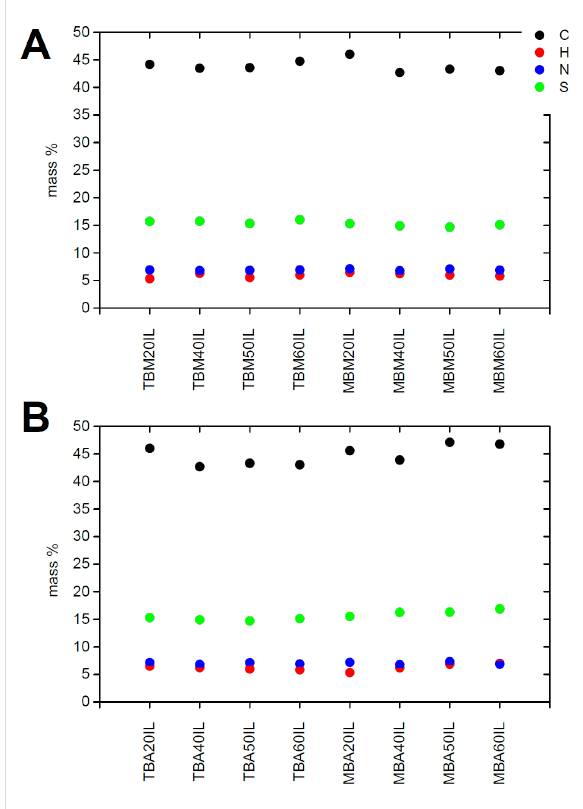
Figure 9: EA data of IGs. Samples shown in panel (A) were made via the methanol-based synthesis and samples shown in panel (B) were made via the acetone-based synthesis of the organosilica. It must be noted here that for reasons described in the Experimental part, there is a slight variation in the IL composition. Moreover, the organisilica com- position also slightly varies from batch to batch. As such it is rather difficult to exactly assign compositions from EA data.